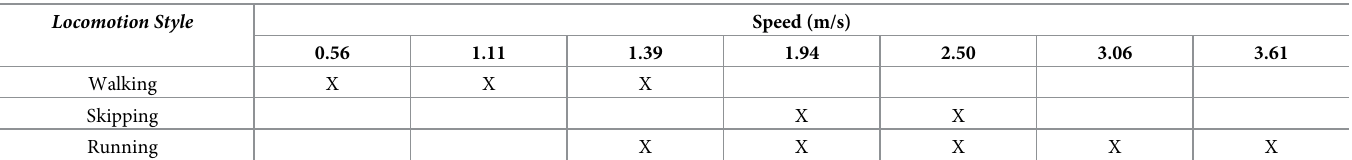
Table 1. Conditions of the locomotion trials.